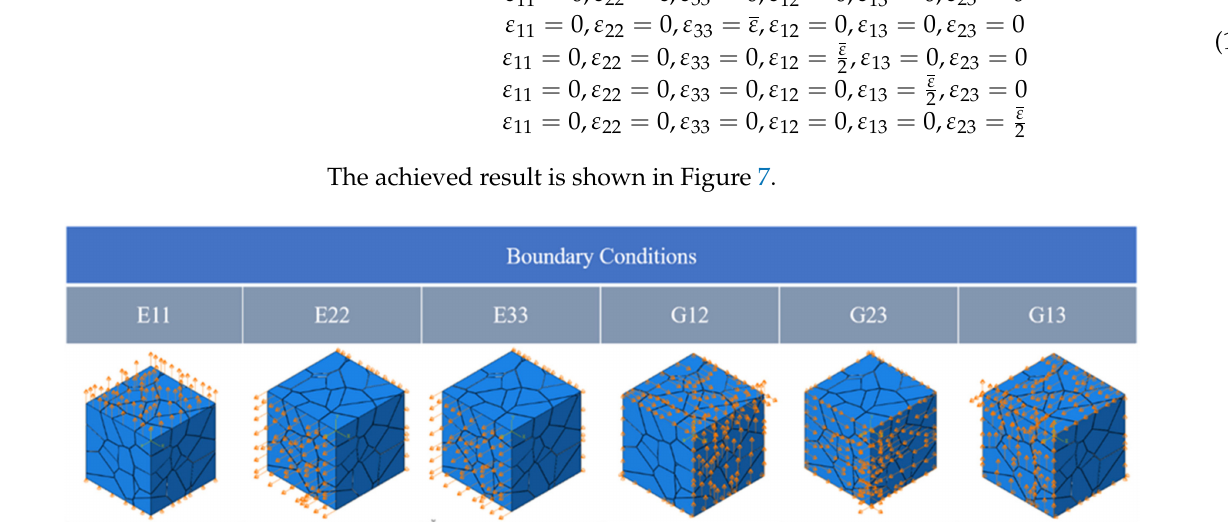
Figure 7. Boundary conditions for the RVE model, E11, E22, E33 represent the tensile boundary conditions in X, Y and Z directions respectively, G12, G23, G13 are the shear boundary conditions in XY, YZ and XZ directions respectively.